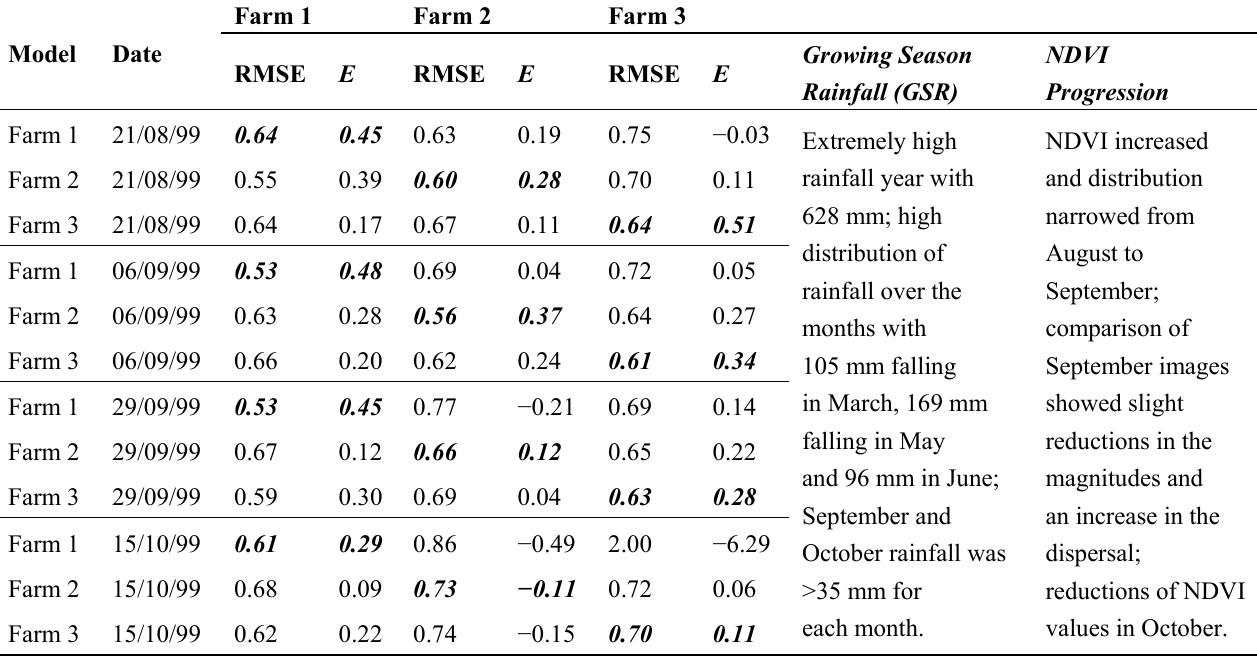
Table 5. Model and yield prediction efficiency criteria for 1999 Landsat imagery-Root Mean Square Error (RMSE) and the Nash-Sutcliffe Efficiency Criteria ( E ). Values in bold italics represent efficiency criteria for the calibration models. Descriptions of 1999 Growing season rainfall, NDVI progression and interpretations of